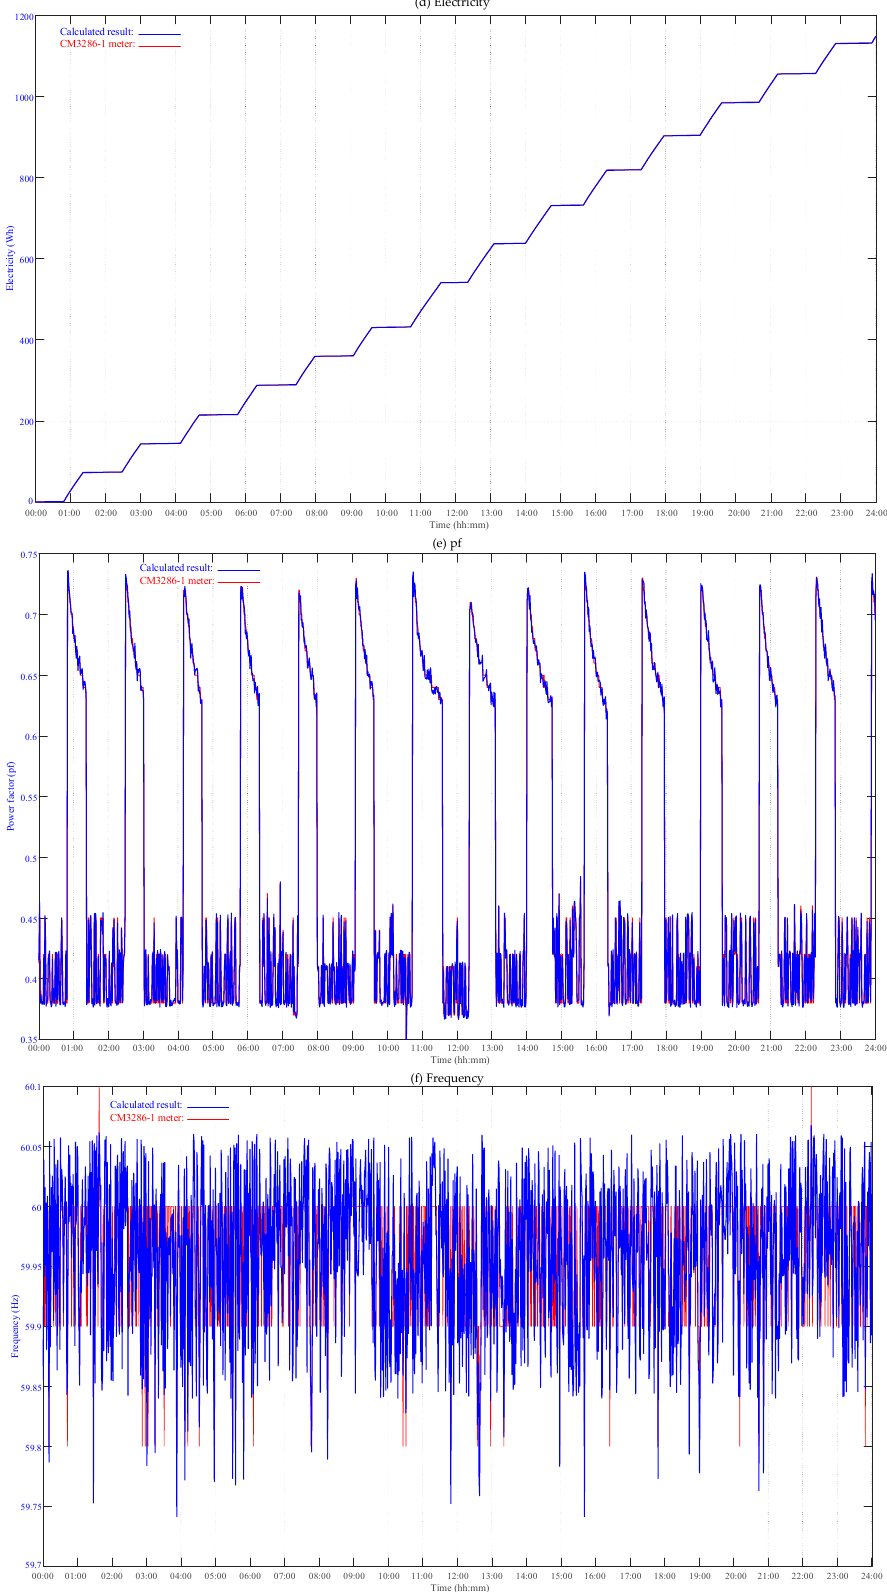
Figure 5. 24-hour measurement results of refrigerator: (a) Voltage; (b) Current; (c) Electric power; (d) Electric energy; (e) Power factor (pf); (f) Frequency (Hz).